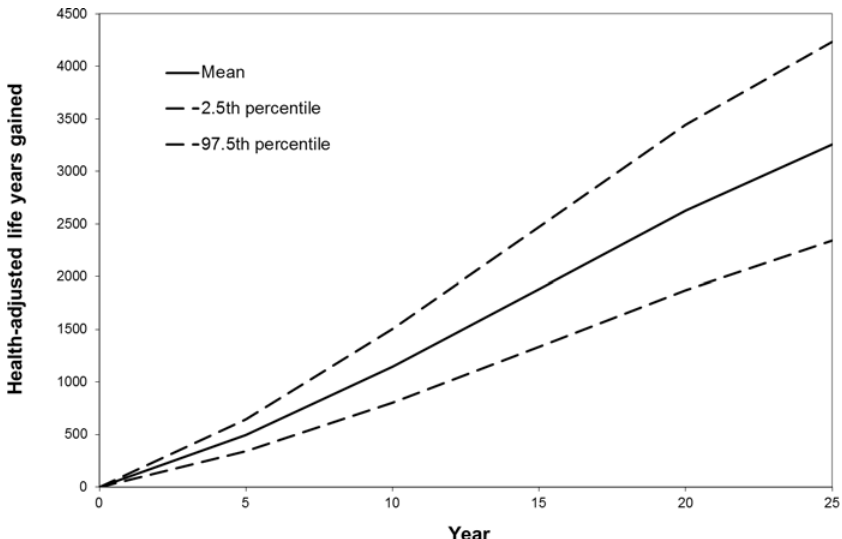
doi:10.1371/journal.pone.0151460.g001